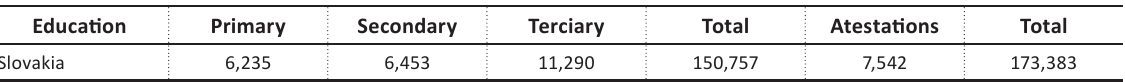
Table 6. State expenditures for one physician study according to OECD data per student and year of study in USD